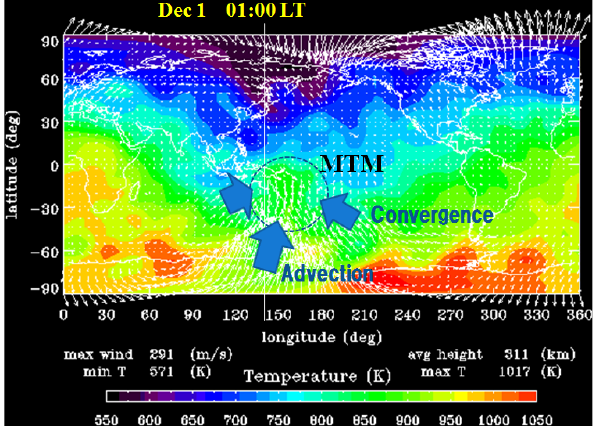
Fig. 9. Same as Fig. 1d except for 16:00UT on 1 December and the colour scale of the contour